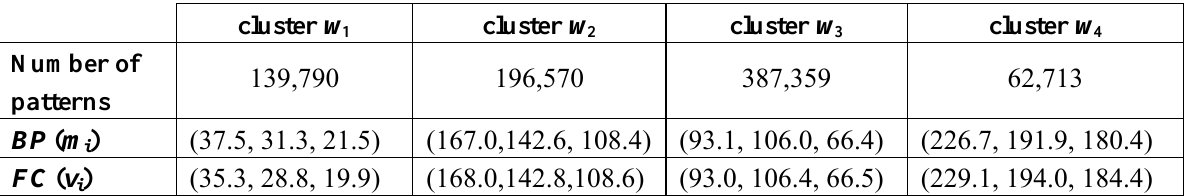
Table 1. Number of patterns used for training and class centres obtained for each class according to the simple classifiers FC and